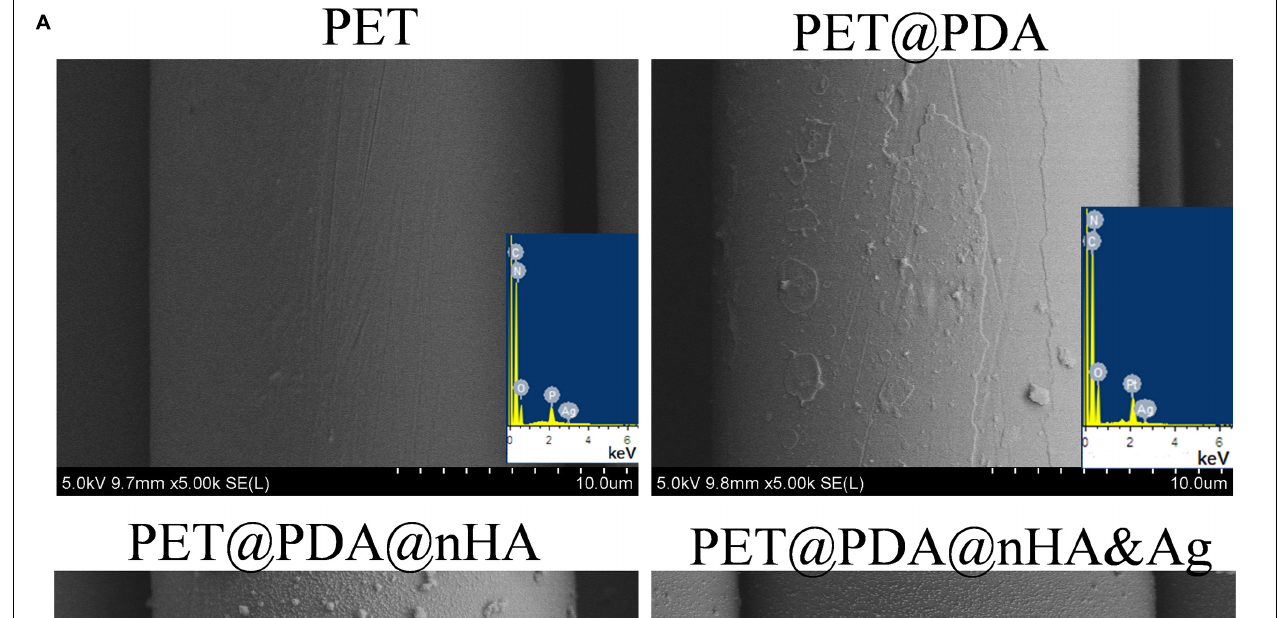
FIGURE 6 | SEM and eds of four PET ligaments (A) , weight percentage of five element (B) and Ag (C) in PET@PDA@Ag and PET@PDA@nHA&Ag ligaments.